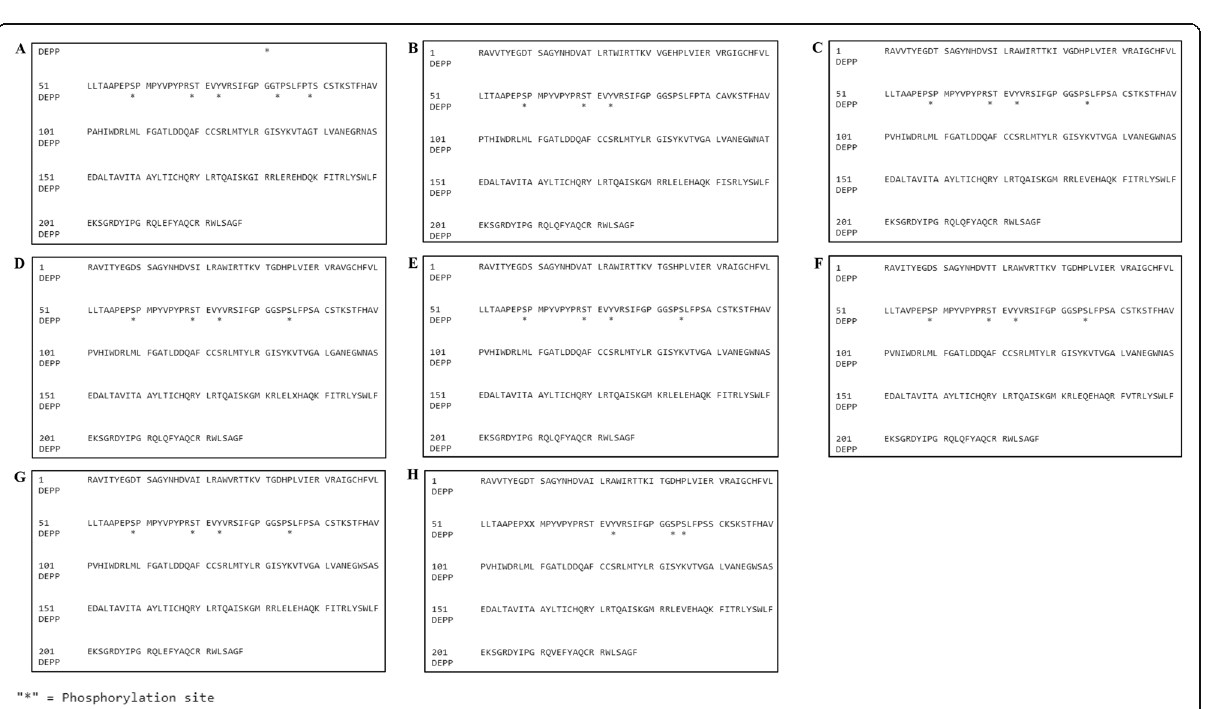
Fig. 9 Depiction of phosphorylated residues within HEV YDR ( A ) JF443720 (GT 1); ( B ) M74506 (GT 2); ( C ) AB222182 (GT 3); ( D ) GU119961 (GT 4); ( E ) AB573435 (GT 5); ( F ) AB602441 (GT 6); KJ496143 (GT 7); and ( H ) KX387865 (GT 8). The was carried out using DEPP (Disorder Enhanced Phosphorylation Predictor). The predicted phosphorylated residues in the YDR proteins are marked with asterisk